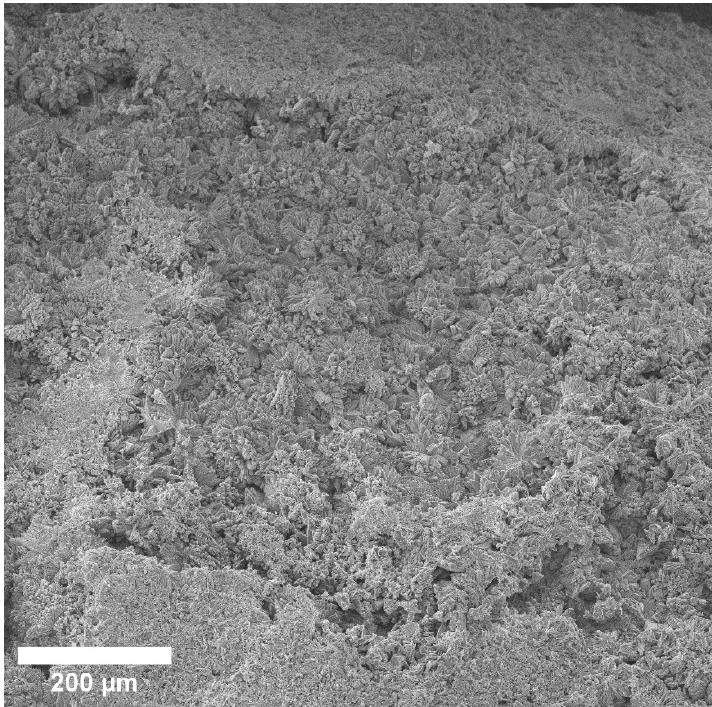
Figure 8. Spherical discharges located on site of bone implant.